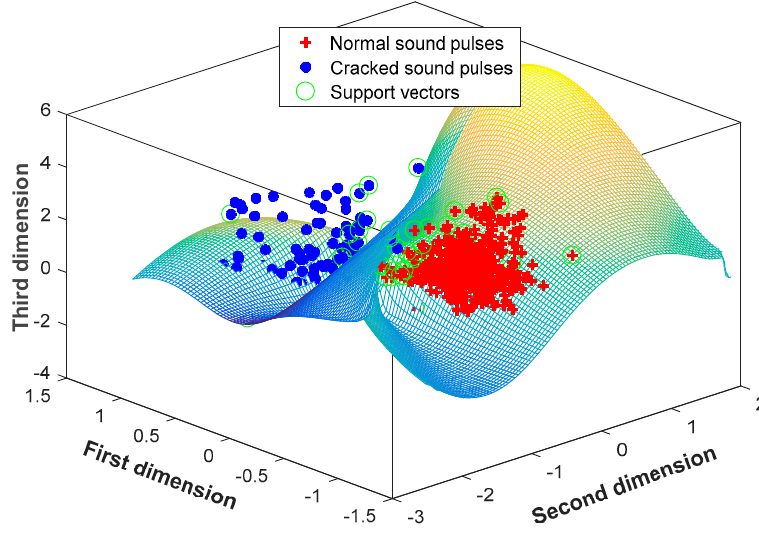
Figure 12. The trained hyperplane with the three principal components.